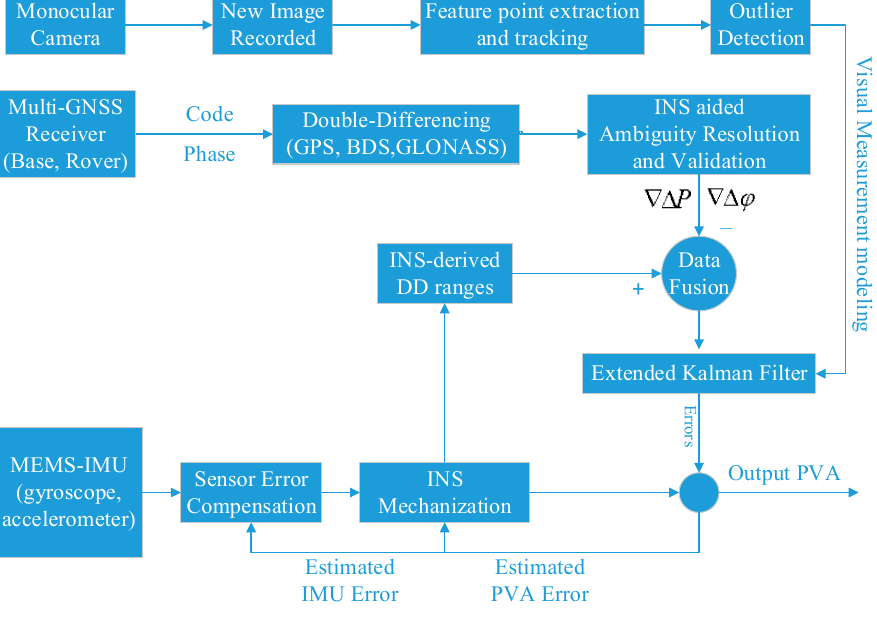
Figure 1. Algorithm structure of the tightly coupled integration of the monocular camera, MEMS-IMU, and multi-GNSS RTK. GNSS: global navigation satellite system; GPS: global positioning system; BDS: BeiDou navigation satellite system; GLONASS: GLObal NAvigation Satellite System; INS: inertial navigation system; DD: double-differencing; IMU: inertial measurement units; PVA: position, velocity, and attitude; MEMS: microelectromechanical system; RTK: real-time kinematics; ∇ ∆ P : DD code measurements; and ∇ ∆ ϕ : DD phase measurements.